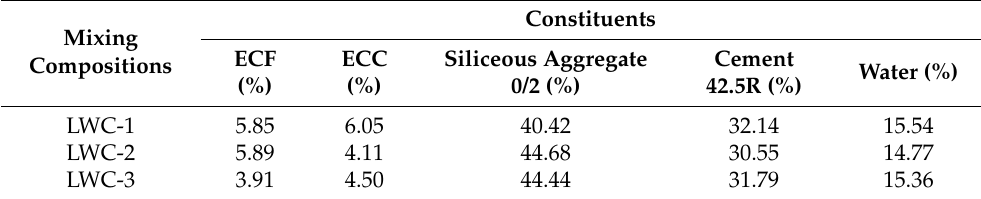
Table 1. Mixing proportions of lightweight concretes in mass